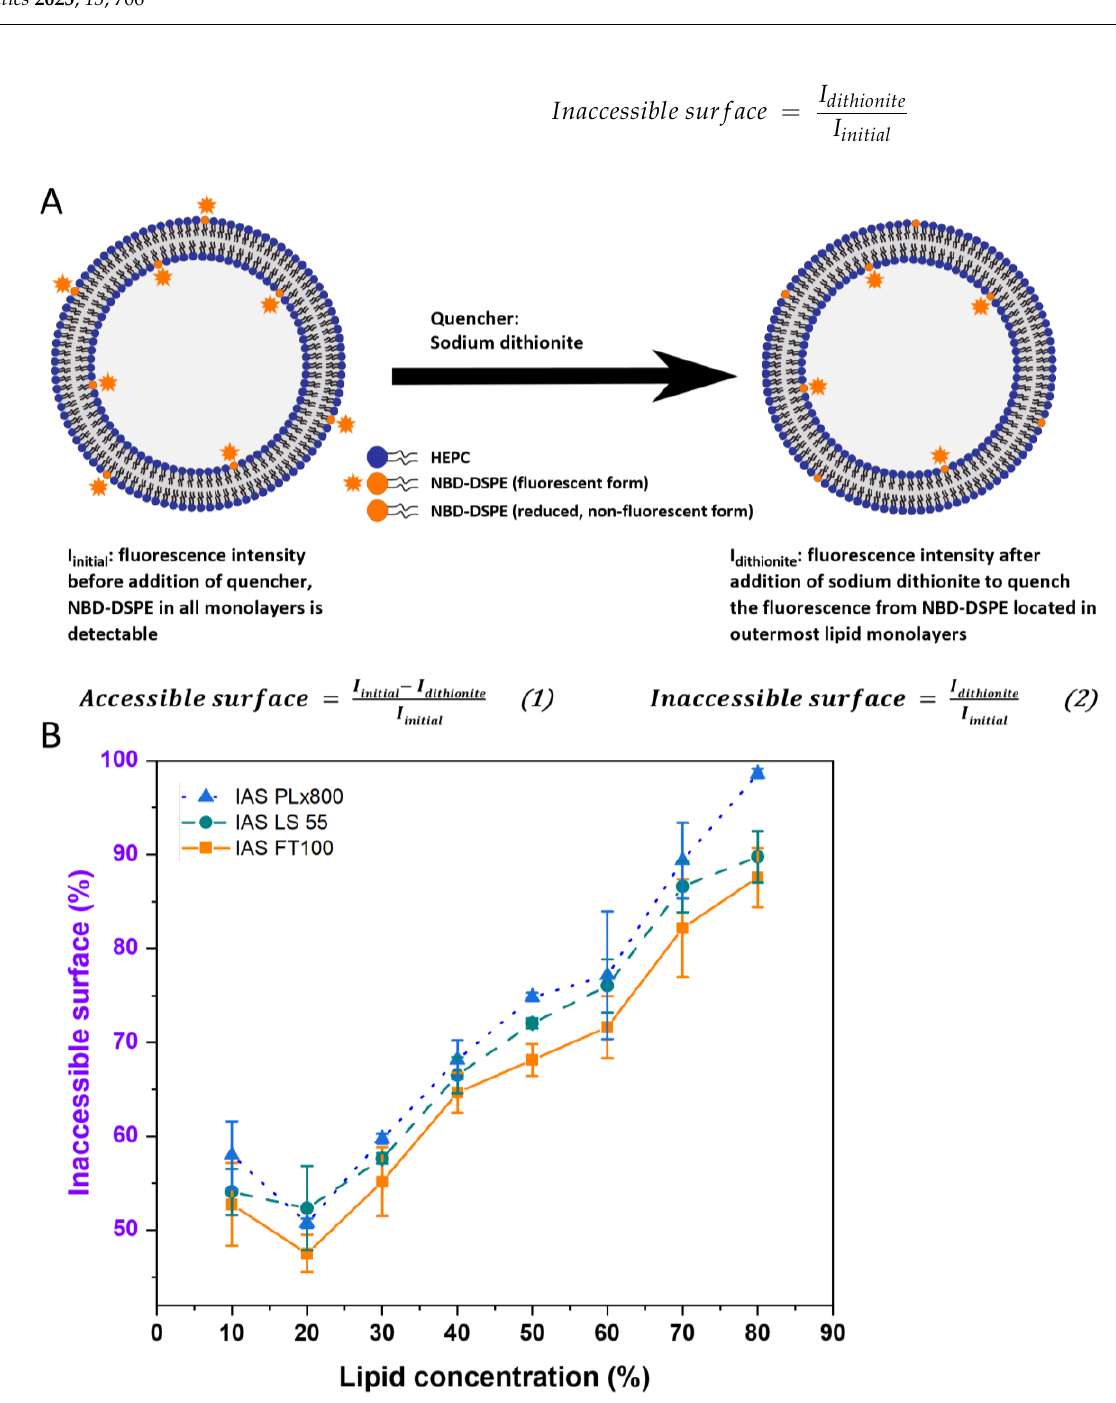
Figure 1. ( A ): Schematic illustration of the inaccessible surface (IAS) assay (for details, see text). ( B ): Inaccessible surface (IAS) assay with different fluorescence determination methods (averaged time-resolved fluorescence: FT100, steady-state fluorescence in a cuvette: LS55 and steady-state fluorescence in a 96-well plate: PLx800) using the example of HEPC/Chol/NBD-DSPE 54.9/45/0.1 (mol%) liposomes prepared by DC (2350 rpm, 30 min, and 20 °C) and redispersed by DC (1500 rpm, 2 min, and 20 °C). Data are shown as the mean ± SD (n = 3).